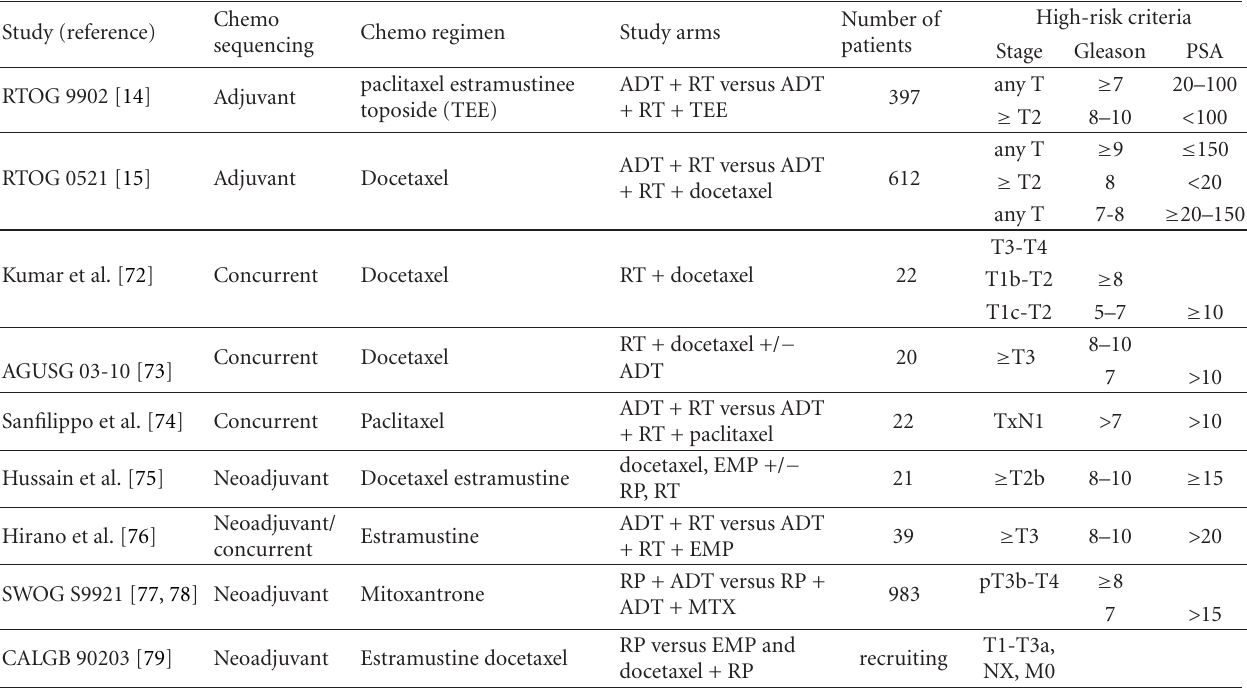
Table 4: Summary of randomized control trials involving chemotherapy for high-risk localized prostate